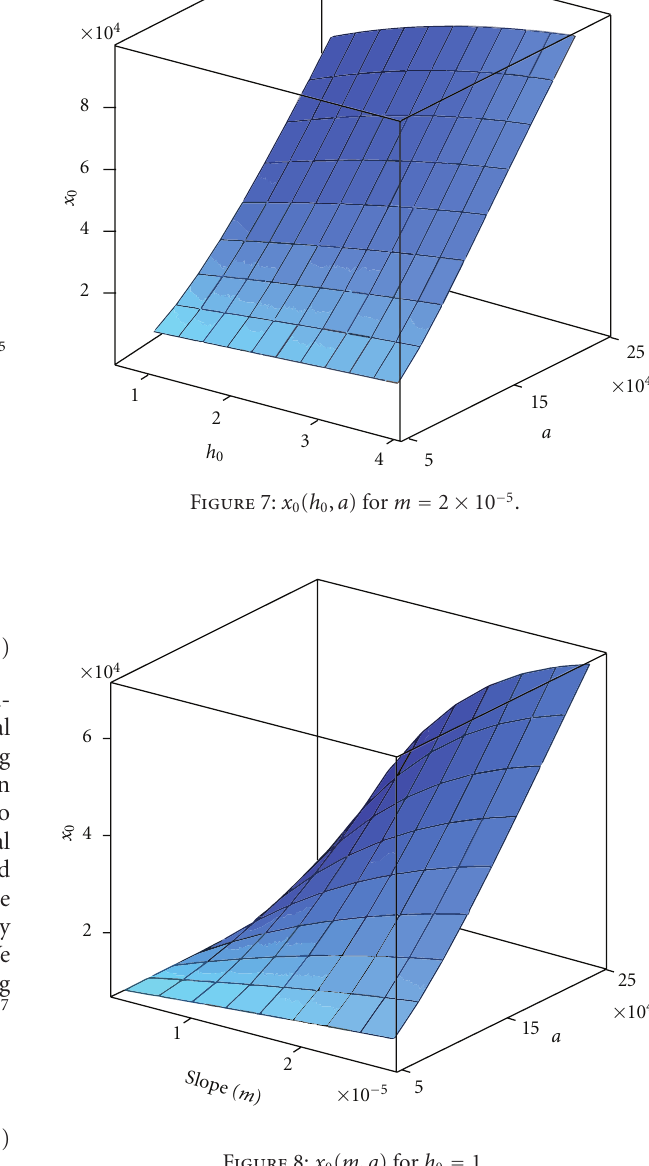
Figure 8: x 0 ( m , a ) for h 0 =